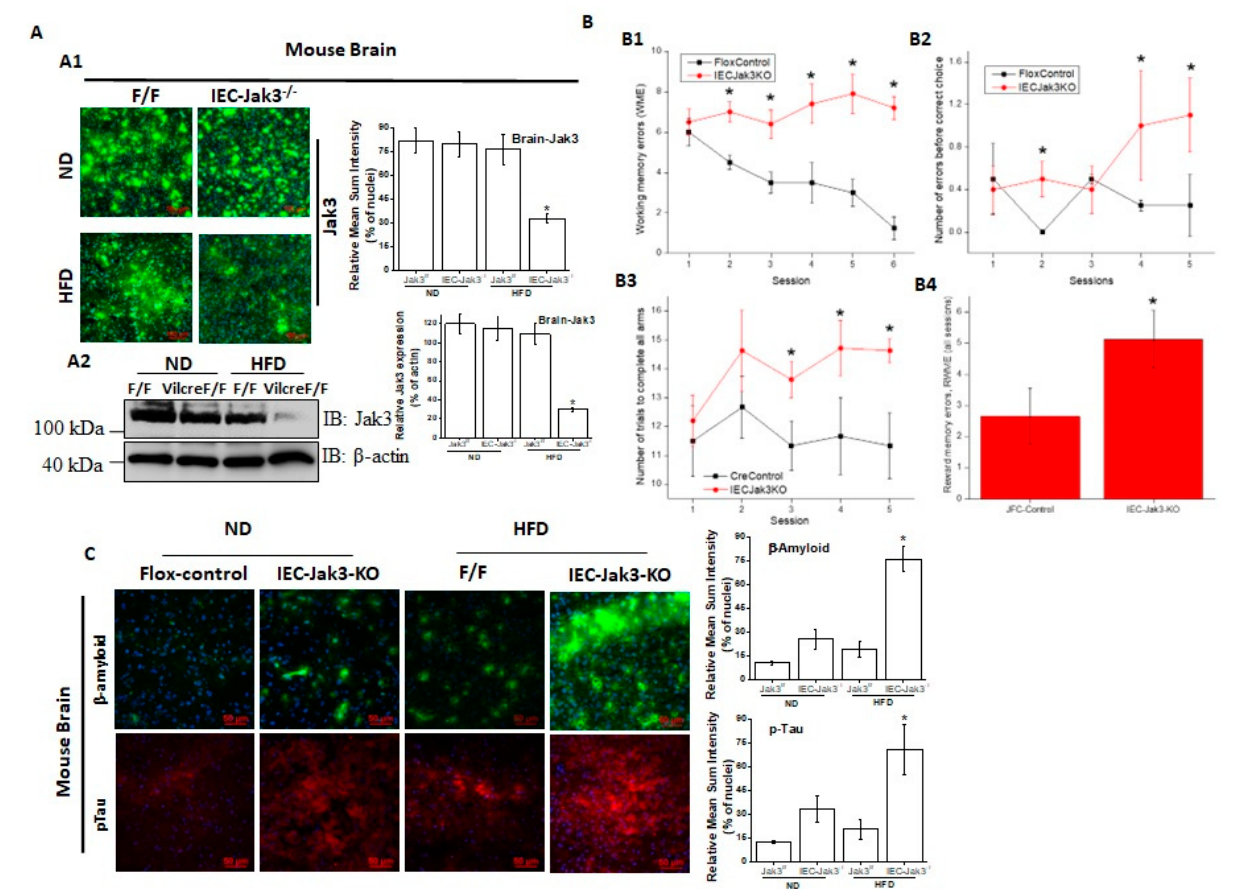
Figure 3. IEC deficiency in Jak3 is responsible for cognitive impairment and increased cerebral cortex accumulation of A β and pTau during HFD-induced obesity: ( A ) IEC-Jak3 deficiency promotes HFD-mediated impacts on Jak3 expression in the brain in mice. Brain tissue sections ( A1 ) or tissue-lysates ( A2 ) from FL-control and corresponding IEC-Jak3-KO littermate mice fed with either ND or HFD were immunostained or Western blotted using Jak3 primary antibodies followed by FITC- or HRP-conjugated secondary antibodies, respectively. Mounting media containing PI were used to visualize the nucleus in A1. Representative images in A1 or blots in A2 ( n = 10 and 3, respectively) are shown (Right panels). Quantifications of the florescent intensities in A1 or densitometric analyses in A2 in the corresponding “left panels” were performed using NikonR C1-plus imaging and BioRad software, respectively, and the results were normalized against PI in B1 or β -actin in B2 for Jak3 expression. ( B ) IEC-Jak3 deficiency promotes cognitive impairment during obesity. The four parameters of cognitive assessments, viz., WME ( B1 ), EBCC ( B2 ), RME ( B3 ) and RWME ( B4 ), were measured, as in Figure 1C. A repeated-measure ANOVA on performances of age- and sex-matched Jak3-flox (Flox-control) and littermate controls of IEC-Jak3-KO mice ( n = 10 each group) is shown for each session ( B1–3 ) or an average of all the sessions ( B4 ). Data are representative of three independent experiments. Values are mean ± S.D. * denotes statistically significant compared with flox mice. (A1; p > 0.01, A2; p > 0.05, A3; p > 0.01, A4). ( C ) IEC-Jak3 deficiency promotes accumulation of β -Amyloid and pTau in mouse brain. Brain tissue sections from FL-control and corresponding IEC-Jak3-KO littermate mice fed with either ND or HFD were immunostained using β -amyloid or pTau or Jak3 primary antibodies followed by FITC- or Cy-3-conjugated secondary antibodies. Mounting media containing PI were used to visualize the nucleus. Representative images ( n = 10) are shown (Right panels). Quantifications of the intensities in the “left panels” were performed using NikonR C1-plus imaging software, and the results were normalized against PI for β -amyloid (Upper right) and pTau (Lower right). Values are mean ± S.D. Asterisk denotes statistically significant p > 0.05 compared with flox mice group. ( β -amyloid p = 0.005, pTau p = 0.003). The triggering receptors on microglial cells 2 (TREM2) interact with Jak3 in the brain, and IEC deficiency of Jak3 leads to an impairment of Jak3 interactions with TREM2 in the